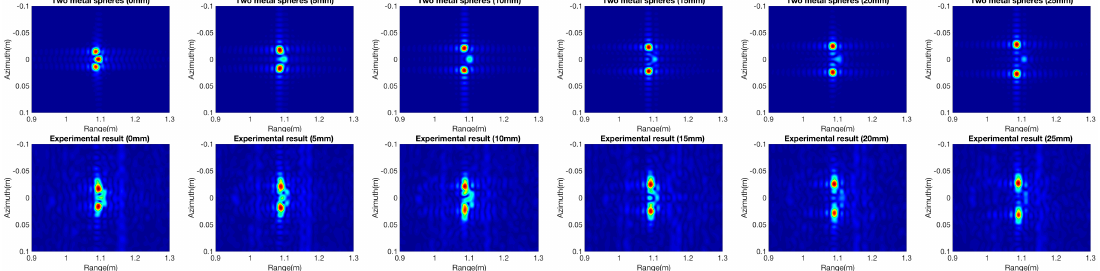
Figure 17. Images of two metal spheres ( top row : simulated; bottom row : experimental) with spacing of 0 mm, 5 mm, 10 mm, 15 mm, 20 mm and 25 mm (from left to right ).